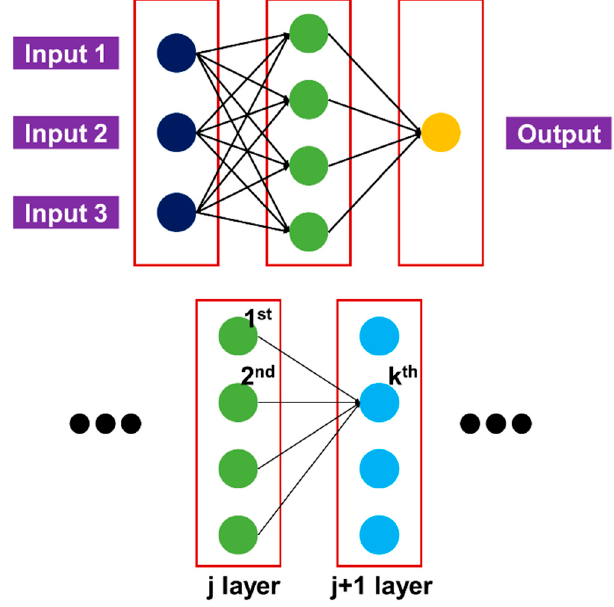
Figure 3. Structure of neural network (NN).